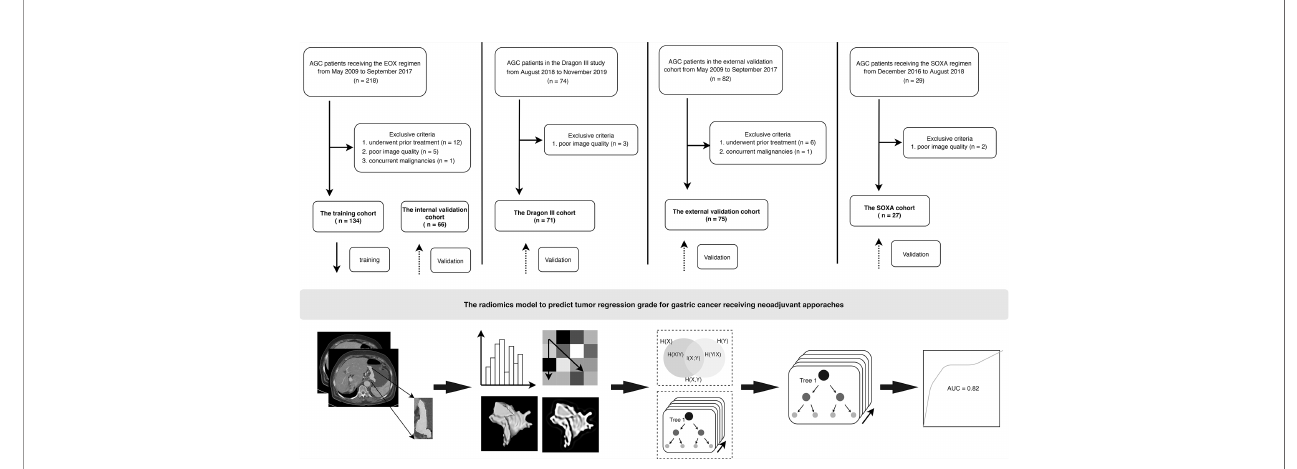
FIGURE 1 | Flowchart and patient enrollment of this study. AGC, advanced gastric cancer. For the regimens, EOX (epirubicin, oxaliplatin, and capecitabine), SOXA (apatinib in combination with S-1 and